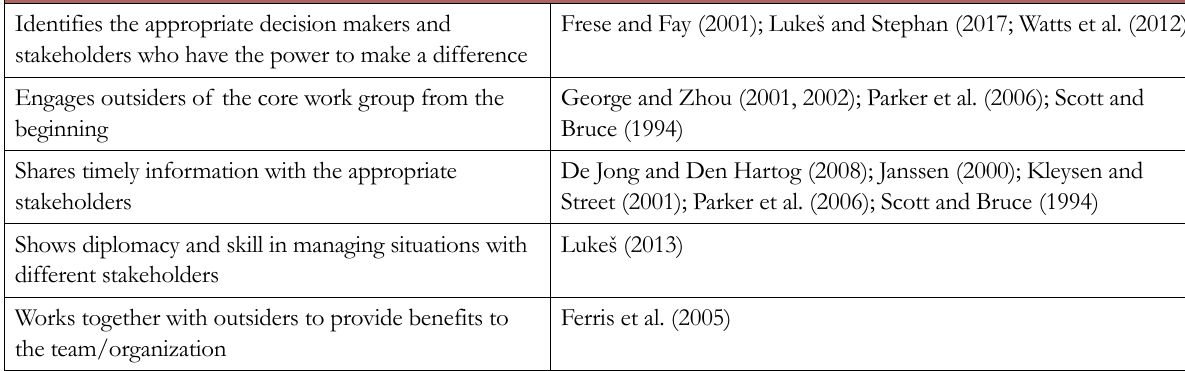
Table 20. Behavioural indicators showing “making the necessary contacts for a project”